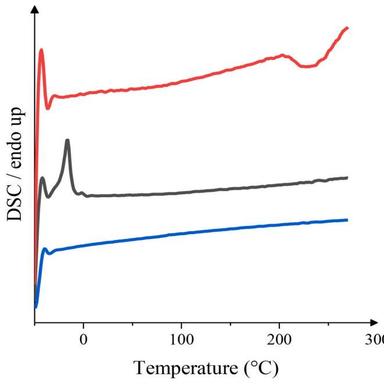
Thermograms of considered HTA: Marlotherm SH (red), MX-4 from Arctic (black), and Kryonaut from Thermal Grizzly (blue), using a heating rate of 30 ◦C/min. (For interpretation of the references to color in this figure legend, the reader is referred to the Web version of this article.)